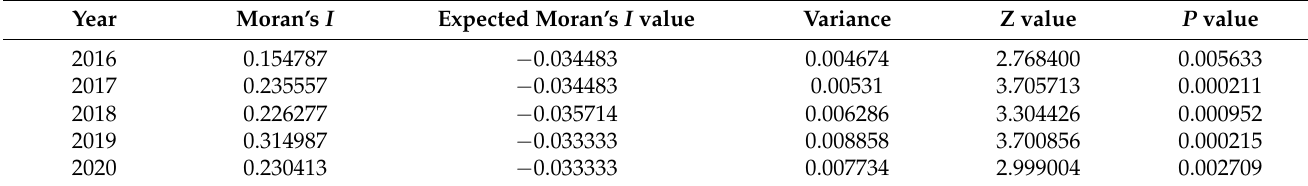
Table 4. Global spatial autocorrelation analysis of Enterobius vermicularis infection among children in China from 2016 to